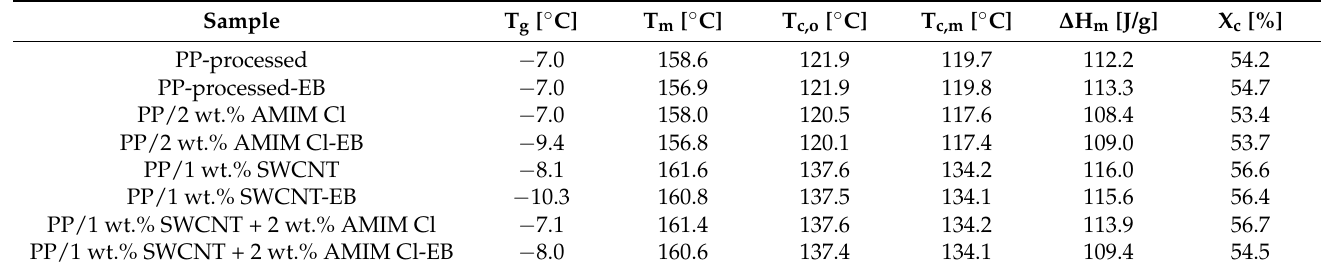
Table 2. Characteristic values of DSC measurements and calculated crystallinities for non-irradiated and irradiated (EB) PP, PP/IL, PP/CNT, and PP-CNT-IL composites; used IL: AMIM Cl, dose 18